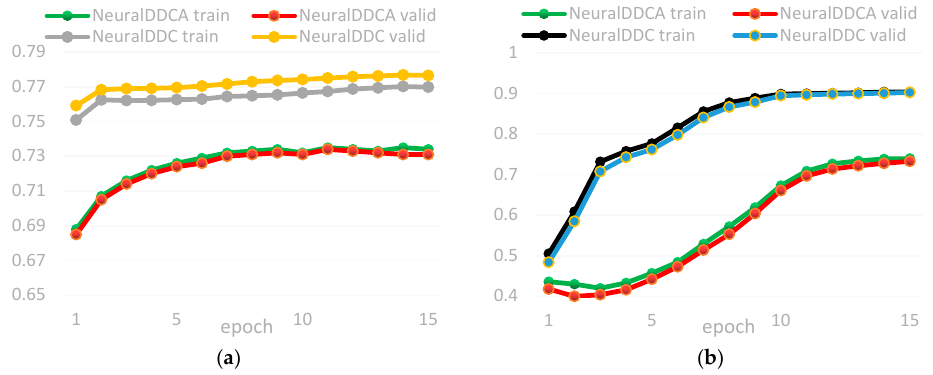
( b ) Figure 2. Model performance comparison of Neu-p1, Neu-p2 and NeuralNCD. 4.5.3. Influence of Neural Network Optimization on the Model It is known from previous work [11] that using neural networks instead of the inter- action functions (e.g., logistic functions, inner products) used in previous cognitive diag- nostic models can be helpful in diagnosing student states. As a result, this study goes on to investigates whether strengthening the neural network’s functions (by incorporating data preprocessing and monotonicity requirements) may enhance the model’s perfor- mance in this part. In this paper, the data preprocessing mechanism of the NeuralNCD is